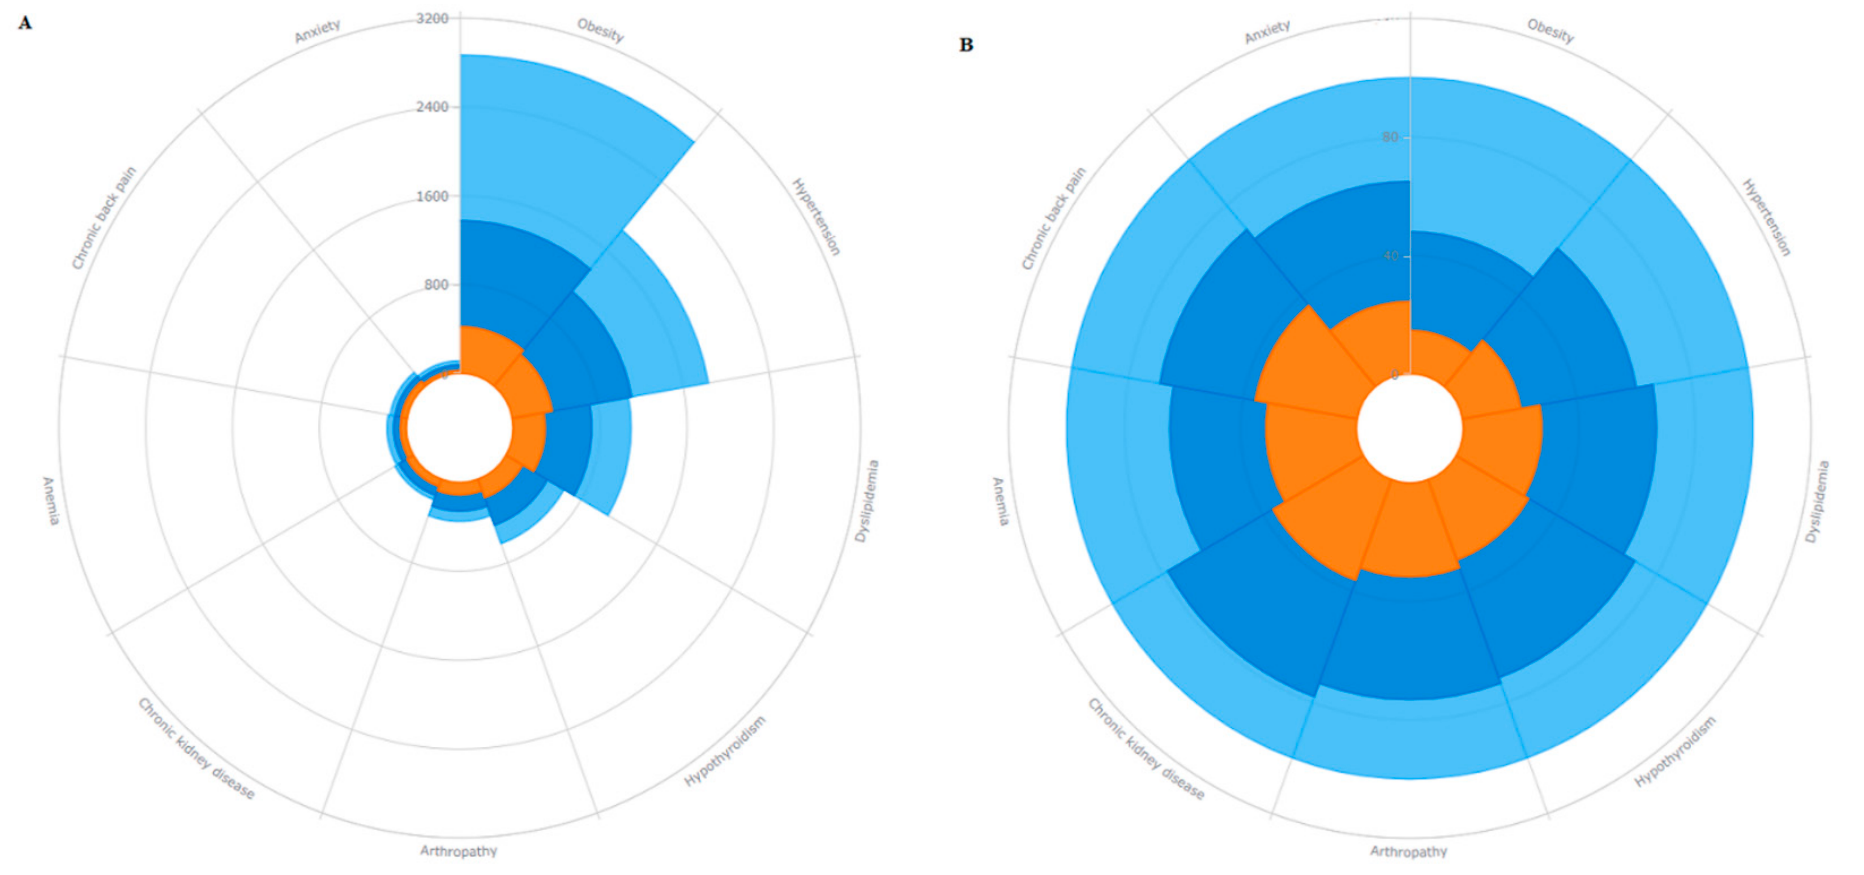
Figure 1. Distribution of morbidities by number of chronic conditions among T2DM cases: ( A ) The absolute number of cases adding up to the total sample size and ( B ) the relative frequencies related to all subjects within the respective comorbidity. Colors imply the number of chronic conditions in addition to T2DM: light blue (1 chronic condition), dark blue (2 chronic conditions), and orange (3+ chronic conditions).